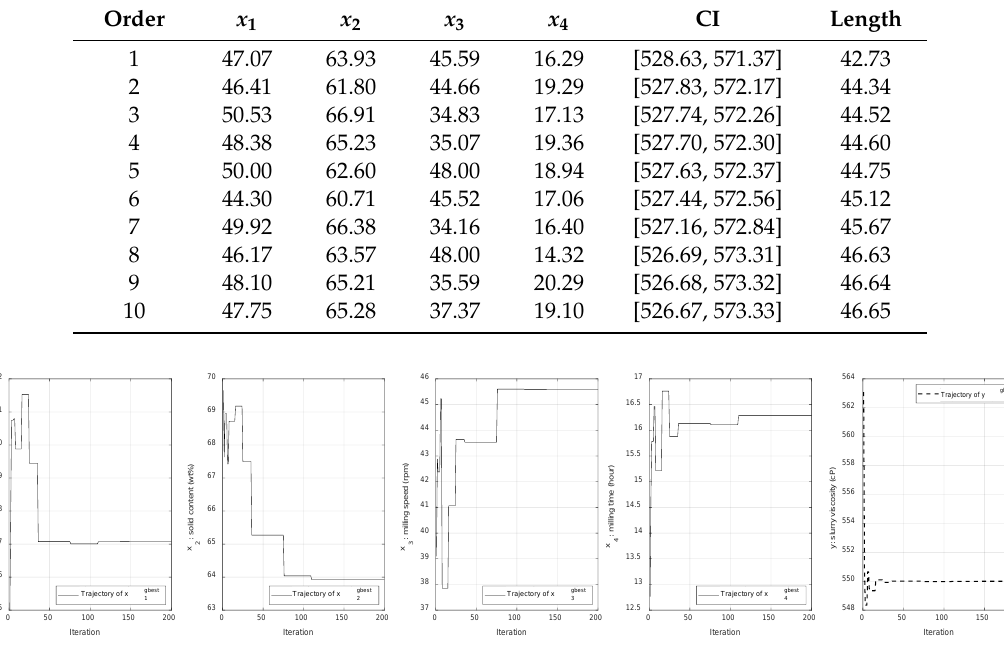
Table 5. ( y target = 550) Results of finding L’ = 10 solutions using the proposed method.